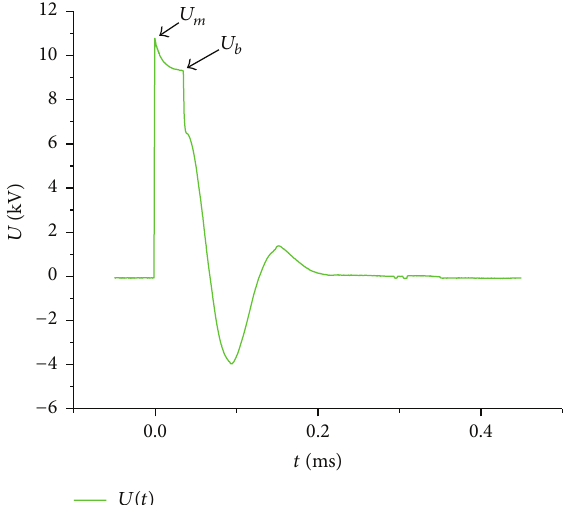
Figure 6: Plot between charging voltage ( 𝑈 𝑚 ) and breakdown voltage ( 𝑈 𝑏 ) under different hydrostatic pressure ( 𝑃 𝑤 ) conditions.